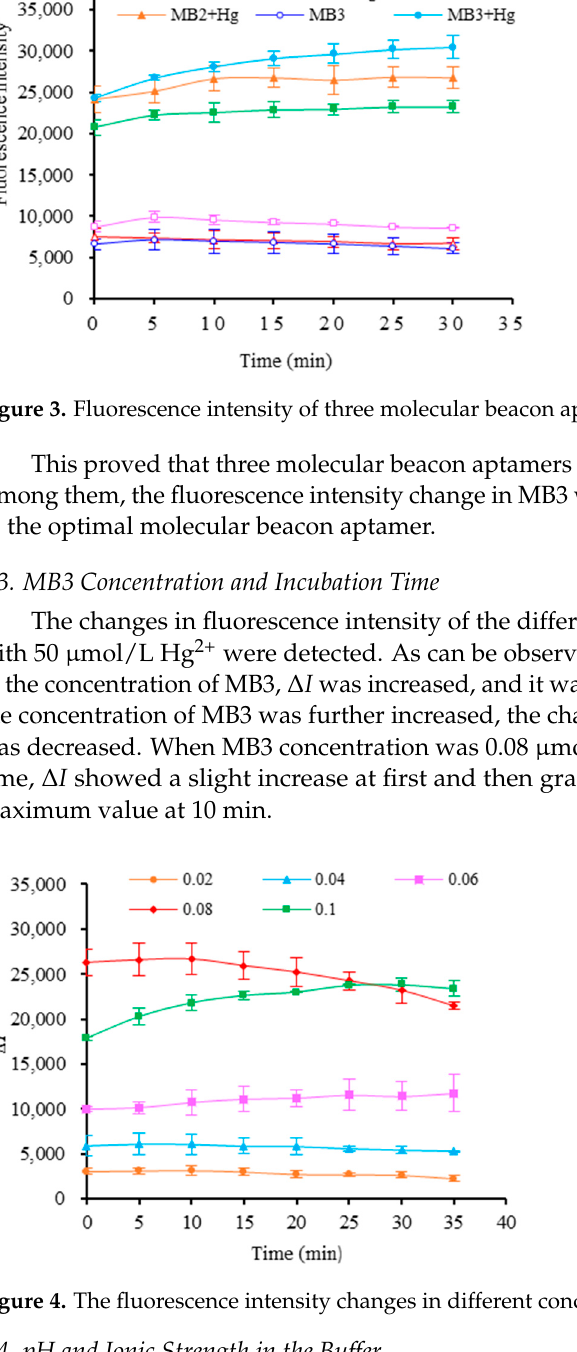
Figure 4. The fluorescence intensity changes in different concentrations of MB3 reacting with Hg 2+ .